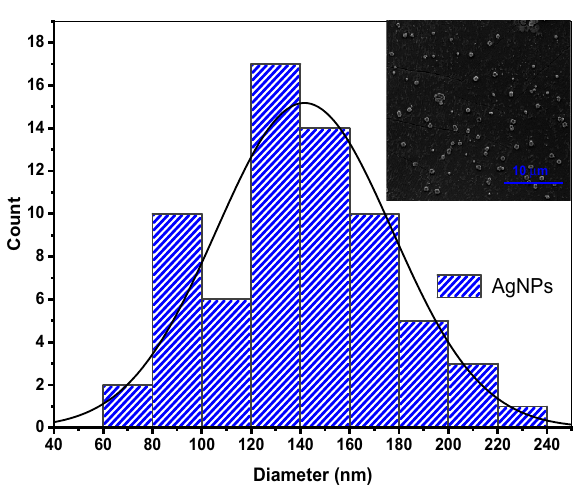
Figure 12. Size distribution of AgNPs embedded within PVA-CNF composite. Inset SEM micrographs of